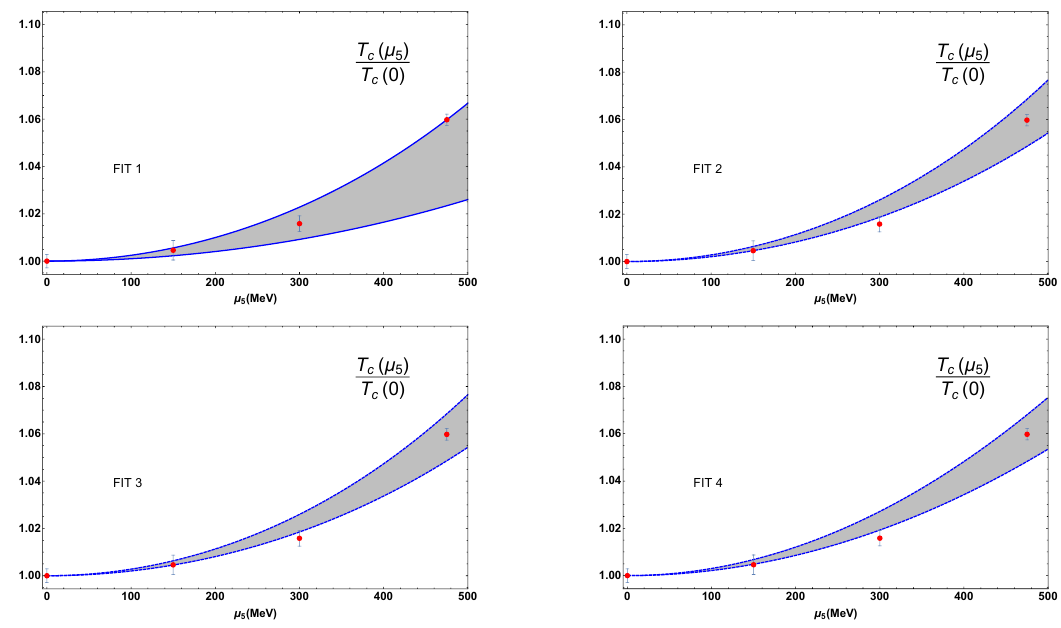
Figure 3 . (cid:22) 5 dependence of the chiral transition temperature extracted from the vanishing of the quark condensate. We show the uncertainty bands corresponding to j (cid:20) a j (cid:20) 1 with (cid:20) a;b de(cid:12)ned in (5.38) and where only (cid:20) a contributes in the chiral limit. We include the lattice points from [20] ( N c = 2) and [21] ( N c = 3), as explained in the main text. The corresponding T c (0) values are 227.1 MeV, and 301.0 MeV for the chiral limit and physical mass curves, and T c (0) = 195 : 8 MeV for [20].